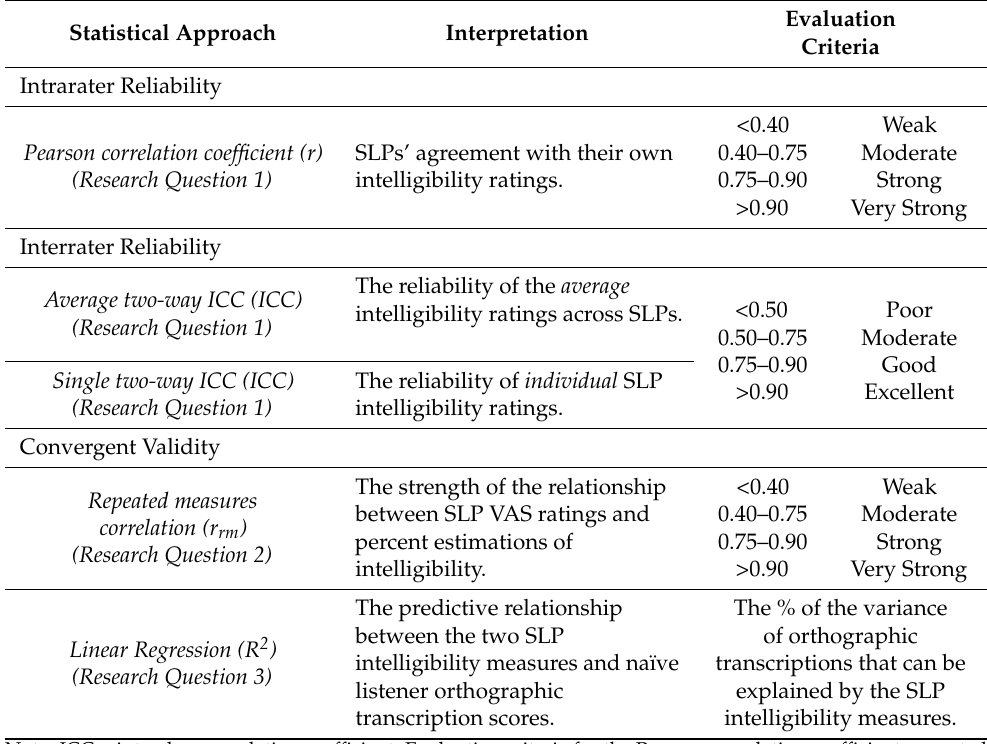
Table 1. Descriptions of the reliability and validity